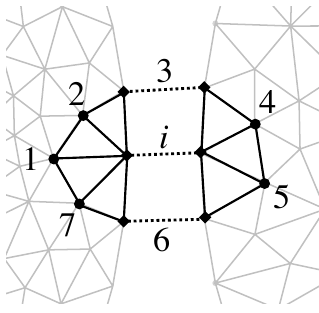
Figure 3. Modification of differential operators to reach into the outer